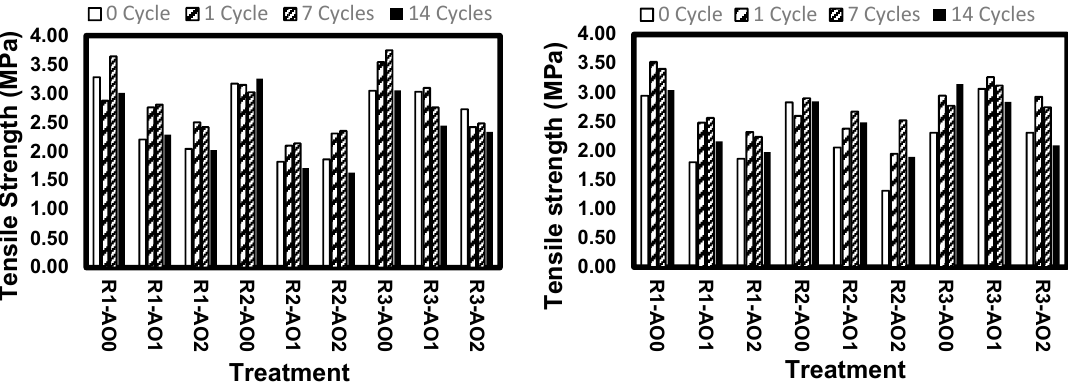
Figure 8. Tensile strength required to pull-off the dollies from white pine (left ) and white spruce ( right ).